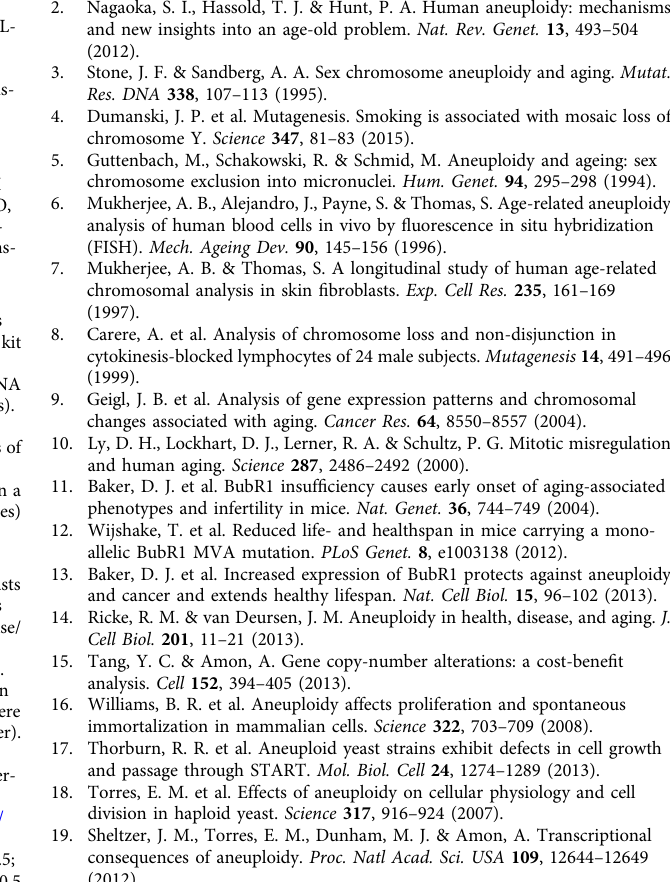
Lentiviral production and infection . Lentiviruses were produced according to the protocol described in Lenti-X Tet-ON Advanced Inducible Expression System (Clontech). Lentiviruses carrying empty pLVX – Tight-Puro, pLVX –– Tight- Puro – H2B – GFP – α -Tubulin – mCherry or pLVX – Tight-Puro – FoxM1-dNdK,